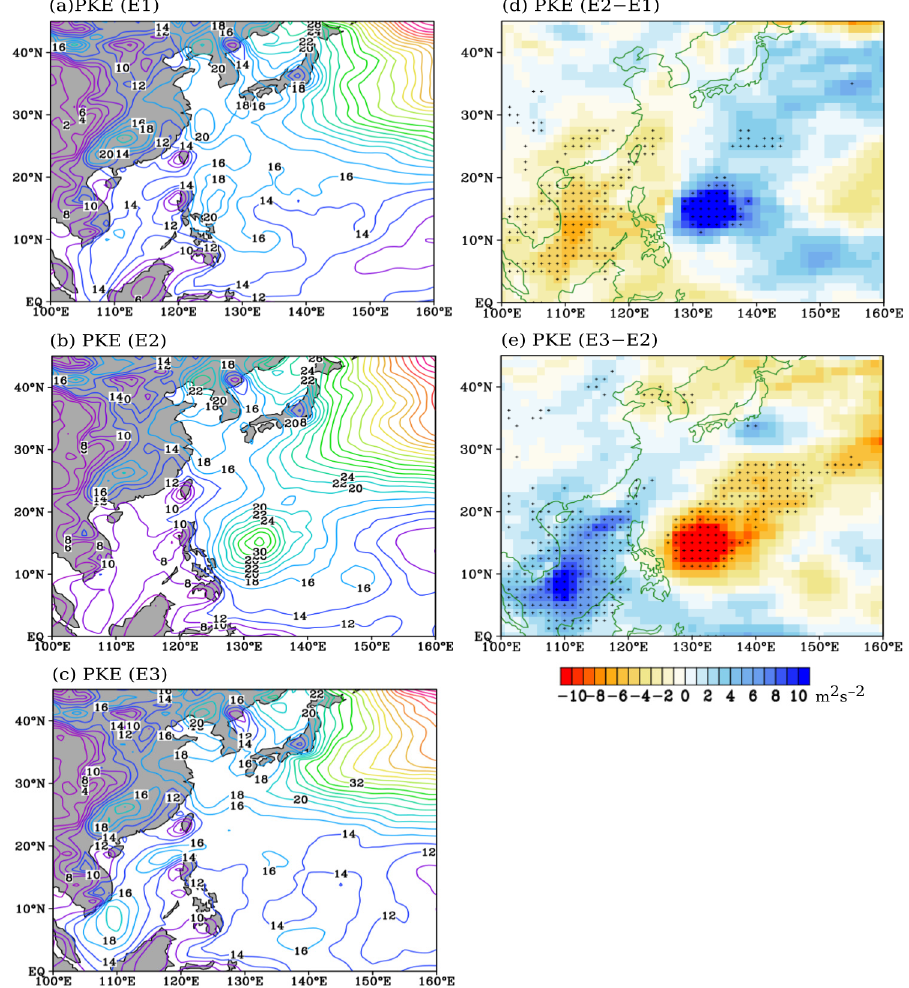
Figure 8. Spatial distribution of the mean 850-hPa perturbation kinetic energy (PKE; m 2 s − 2 ) during December for: ( a ) E1 (1961–1976); ( b ) E2 (1977–1992); and ( c ) E3 (1993–2008). Epochal difference in PKE between ( d ) E1 and E2 (E2 minus E1); and (e) E2 and E3 (E3 minus E2). The contour interval from ( a ) to ( c ) is 2 m. Cross markings in ( d , e ) indicate a significant difference above the 90% confidence level